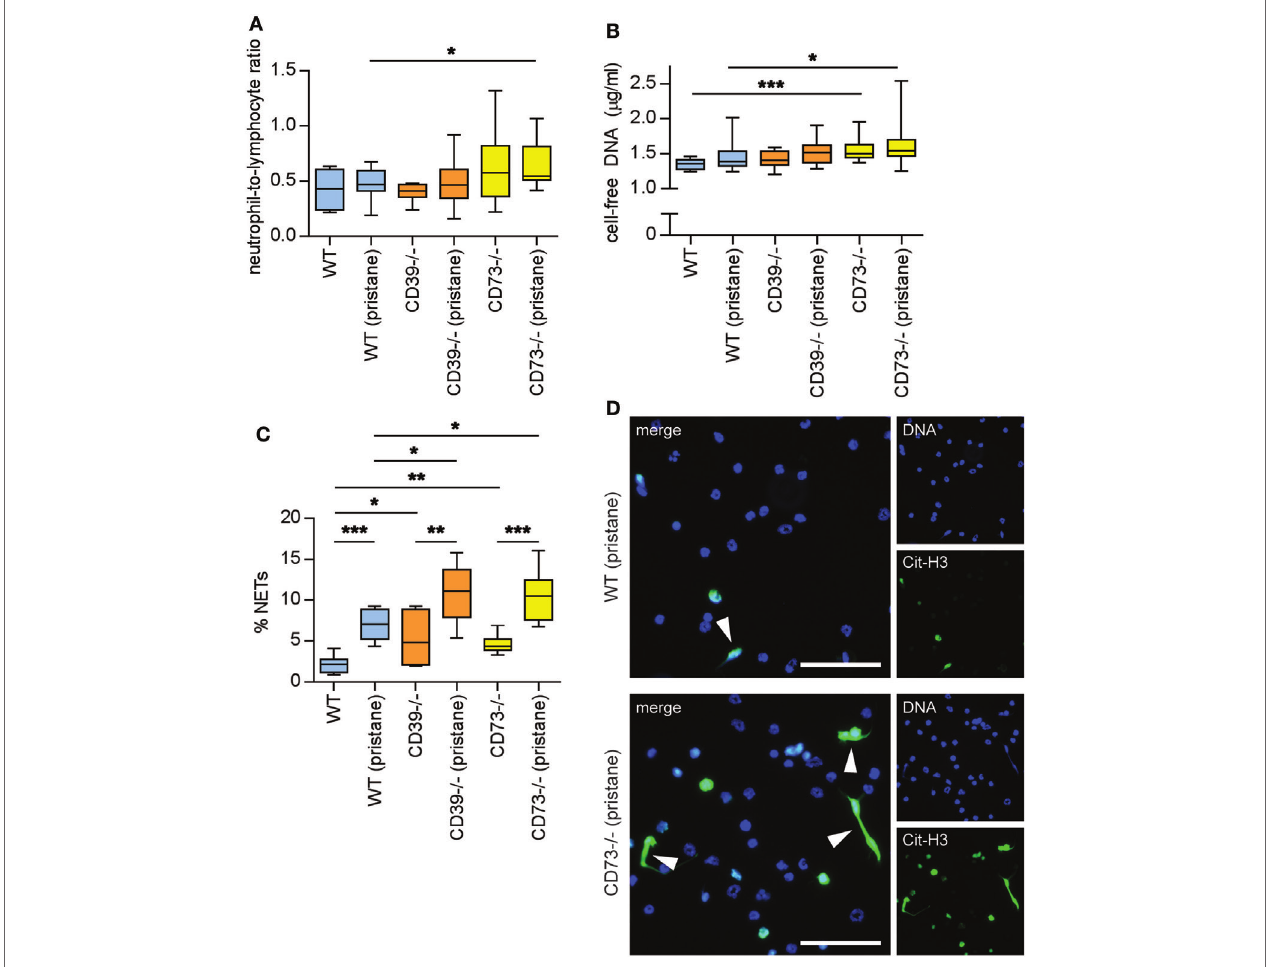
FigUre 6 | Ectonucleotidase deficiency potentiates neutrophil activation. Mice were administered either saline or pristane, as indicated. 36 weeks later, various endpoints were assessed. (a) Neutrophil-to-lymphocyte ratio in peripheral blood. (B) Cell-free DNA in mouse serum. (c) Mature neutrophils were purified from mouse bone marrow and cultured for 4 h on polylysine-coated glass coverslips. Spontaneous neutrophil extracellular trap (NET) release was assessed by immunofluorescence microscopy. (D) Representative photomicrographs from the data presented in panel C. DNA is stained blue and citrullinated histone H3 (Cit-H3) green. NETs are identified as extracellular areas of blue and green overlap (arrowheads). Scale bar = 50 µm. For panels (a,B) , n = 10 per control group and 17–19 per pristane group. For panel (c) , n = 6–9 per group; * p < 0.05, ** p < 0.01, and *** p <